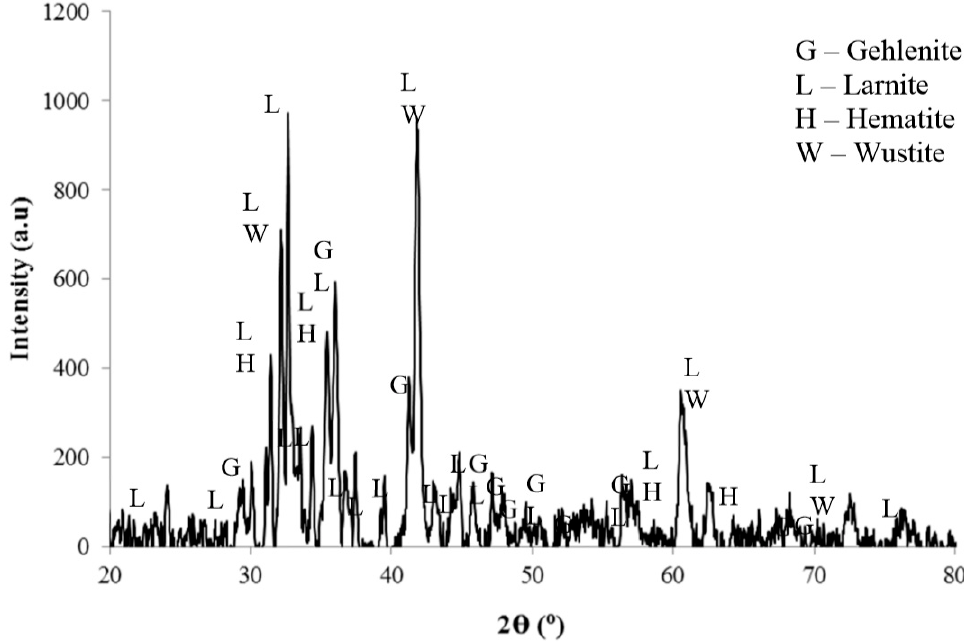
Figure 2. Mineralogical analysis of EAFS .